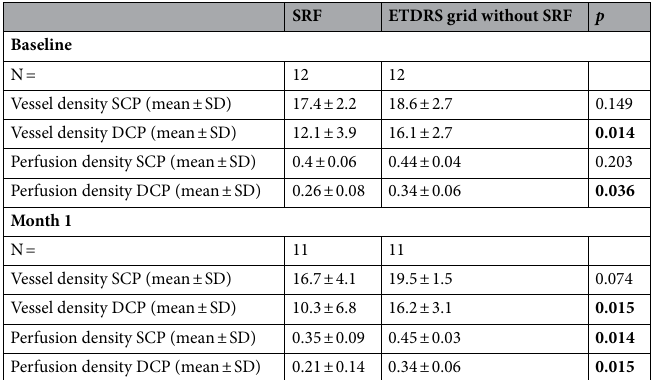
Table 1. Vessel perfusion density analysis for subretinal fluid and ETDRS grid (6 mm). Stastistically signficant p values are marked in bold. SRF subretinal fluid, ETDRS early treatment of diabetic retinopathy study, mm millimetre, SCP superficial capillary plexus, DCP deep capillary plexus, SD standard